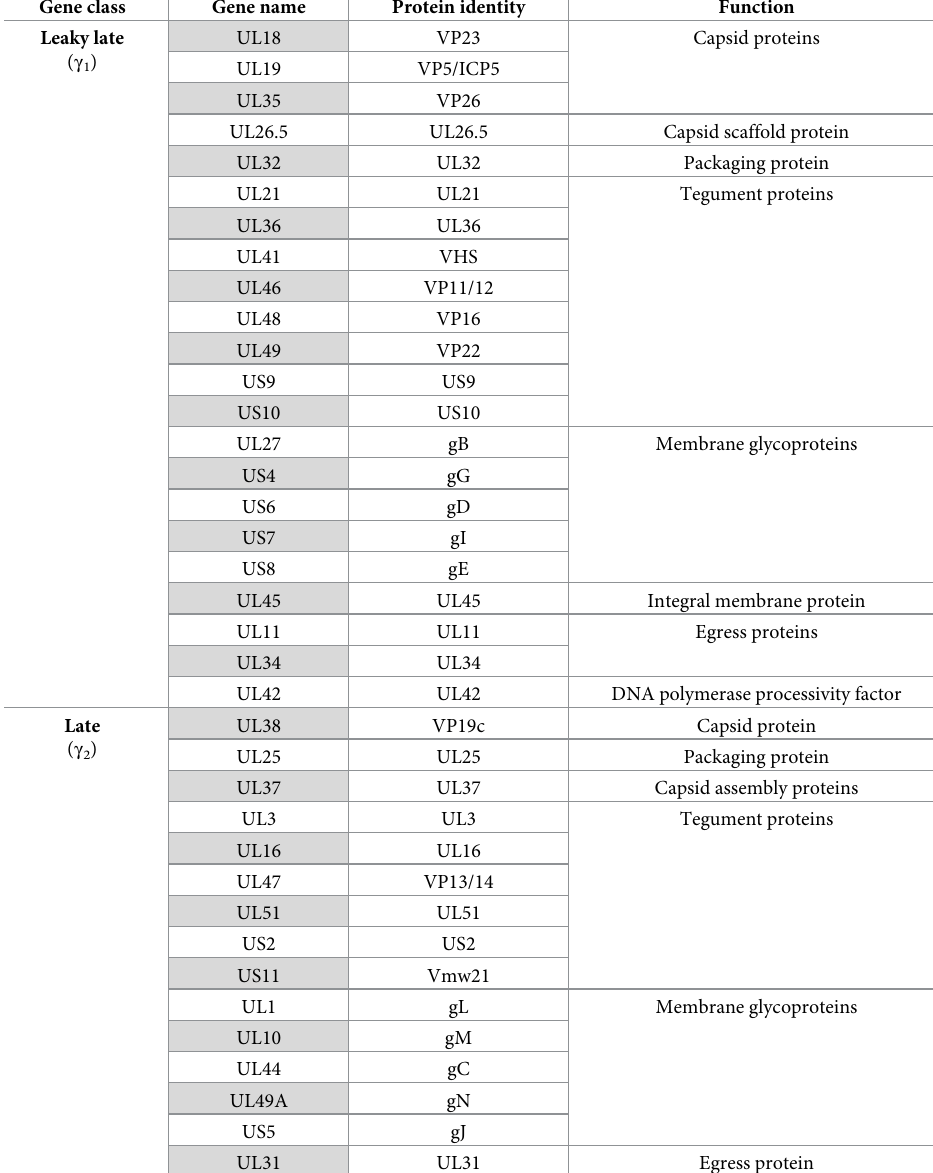
Table 1. Classification of leaky late and late genes, along with their general functions